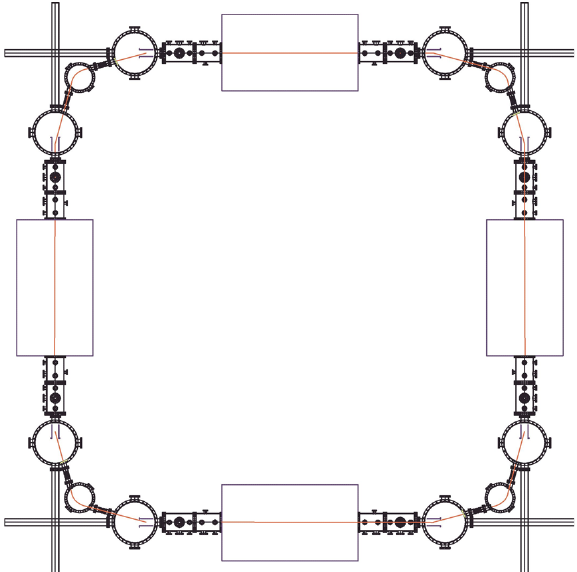
FIG. 2. (Color) Beam envelope calculated with COSY infinity. Transverse dimensions are multiplied by a factor of